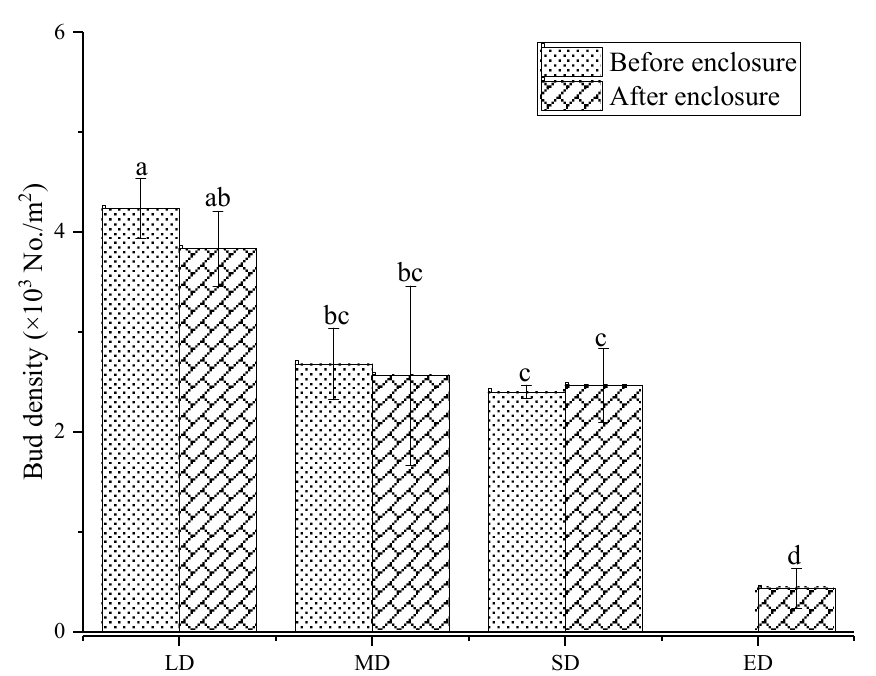
Figure 3. Variation characteristics of bud banks in different desertified grasslands. LD: light desertified grassland; MD: moderate desertified grassland; SD: severe desertified grassland; and ED: extreme desertified grassland. Data with different letters in the same column indicate significant differences at the 0.05 level.